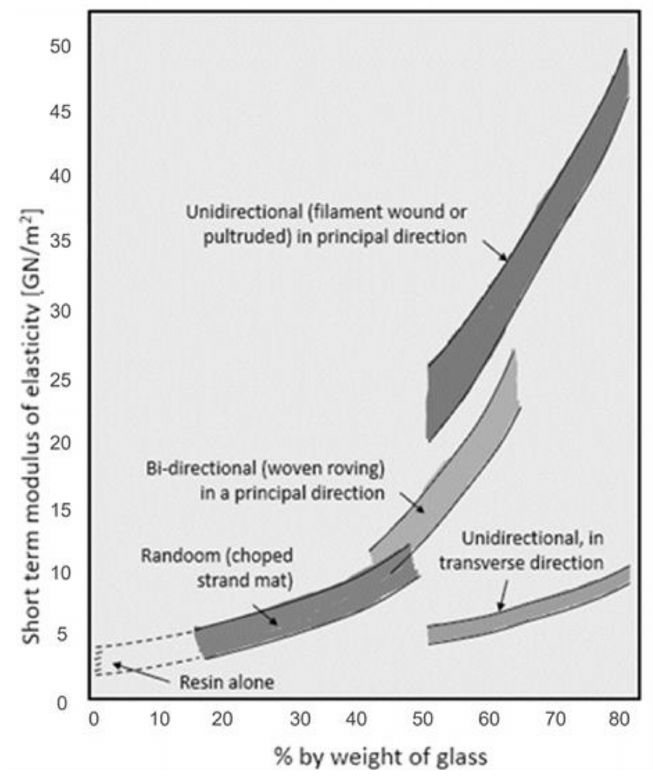
Figure 4. Modulus of elasticity for glass fiber reinforced polymers